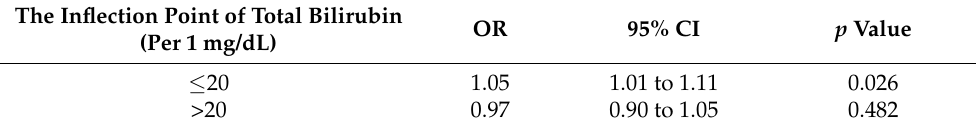
Table 4. The results of two-piecewise regression model. The Inflection Point of Total Bilirubin